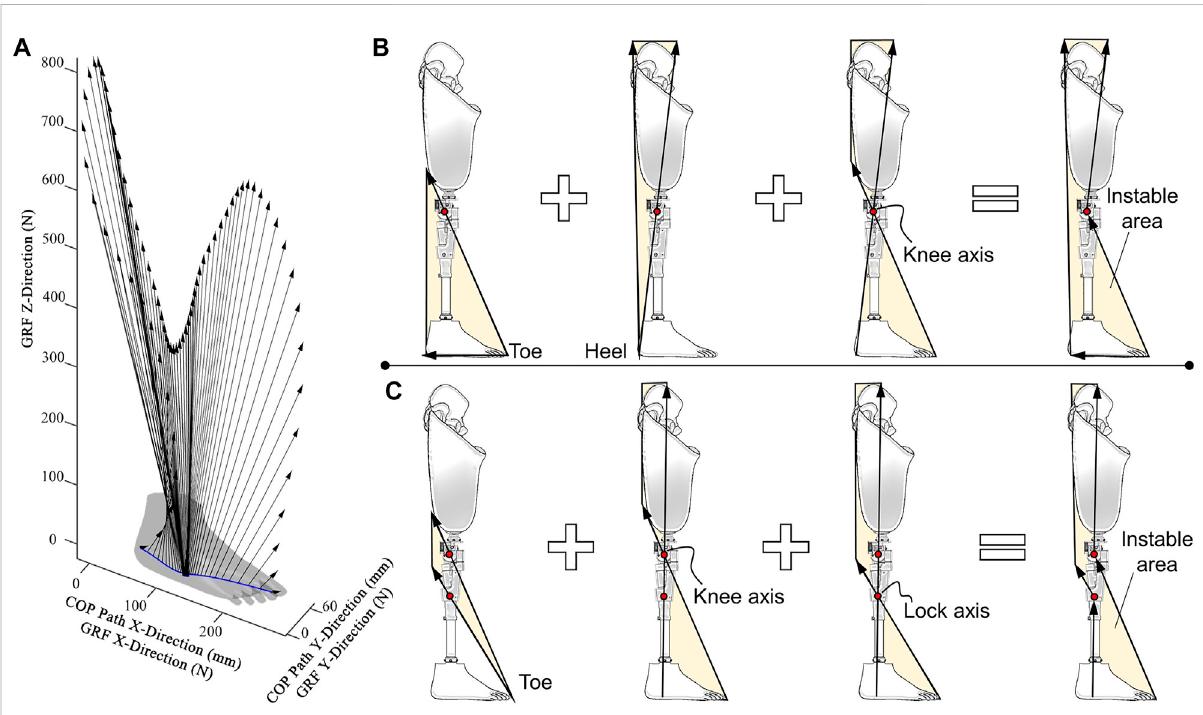
FIGURE 7 Characteristicsoftheknee-axis andlock-axis mechanisms. (A) Ground reaction force(GRF)vectors fromheel-striketo toe-offduring anatural gait. (B) Instability diagram (theyellow area) oftheprosthetic kneeonly withtheknee-axis mechanism. (C) Instability diagram(the yellowarea) ofthe prosthetic knee with both knee-axis and lock-axis